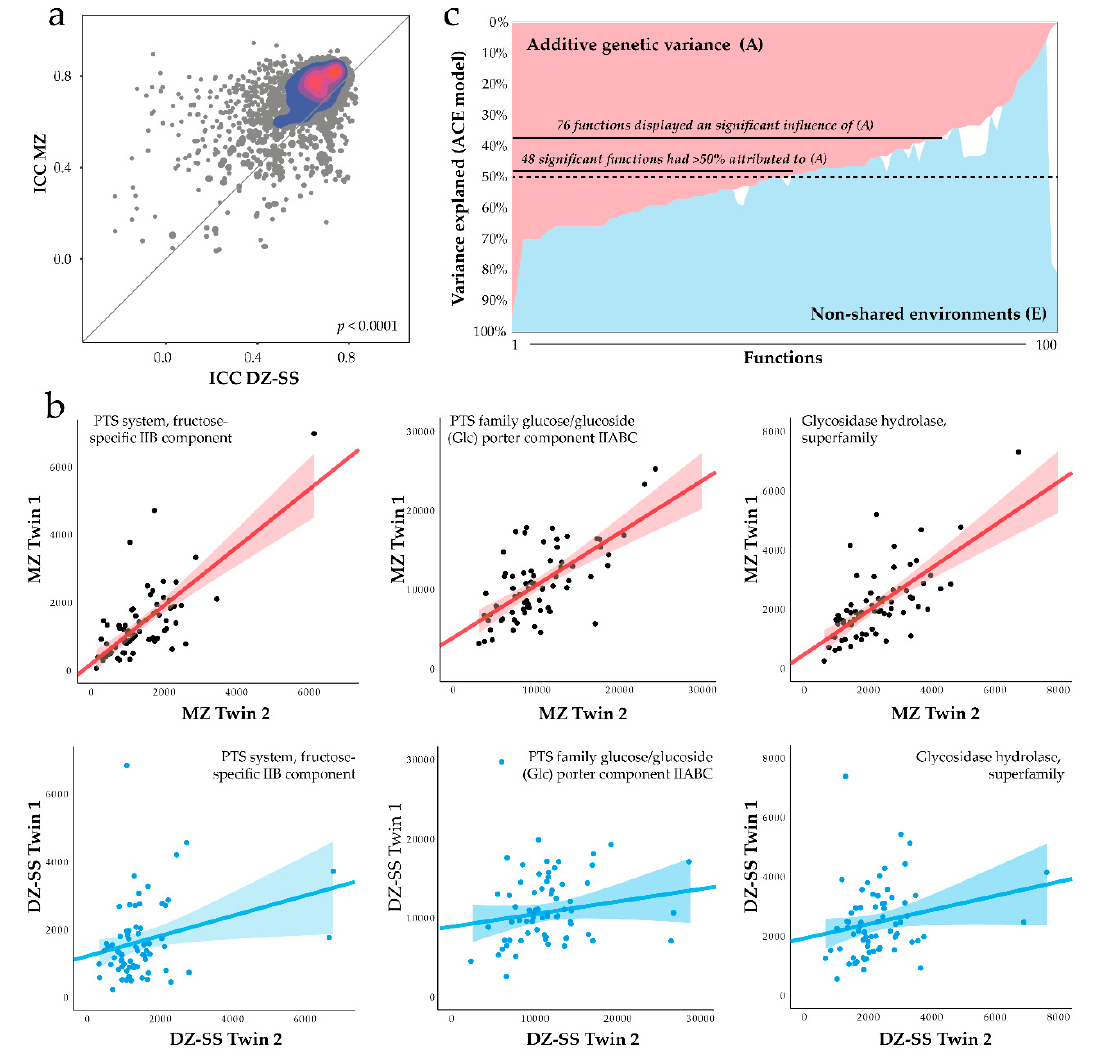
Figure 5. Effect of the host genotype on the microbiota predicted functions. ( a ) ICC between MZ and DZ-SS twins of the predicted functions ( n = 3252, 100% prevalence). Density was predicted using the Kernel estimation. ( b ) 2D-scattered plots of three selected functions suggested to be prominently influenced by host additive genetic effects (A). Trend line with 95% CI is shown. ( c ) Area plot of ACE model estimation for the top 100 selected functions. Variance explained by component C is shown in white. Models were adjusted for birth year, sex, and sequencing batch, and p -values were adjusted using a Bonferroni correction.